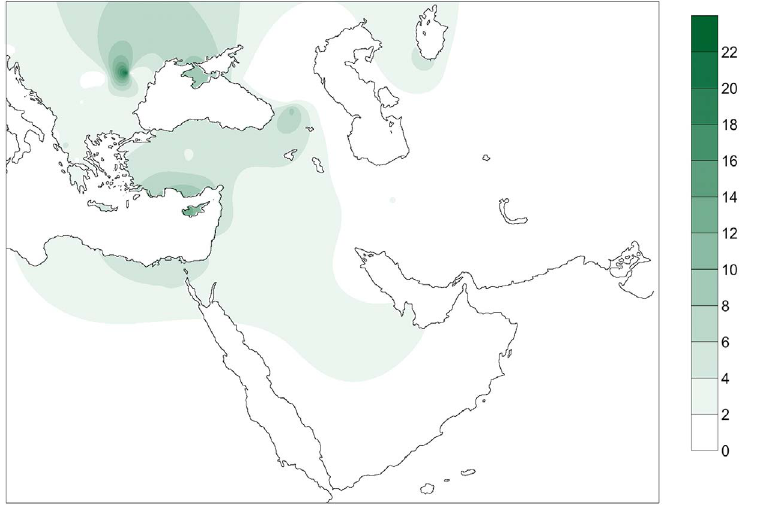
Figure 2. Contour map displaying the percentage of individuals of the database carrying PPNB haplotypes. Only populations with clear geographic distribution were included. Gradients indicate the degree of similarity between PPNB and modern populations (dark: high; clear: small).